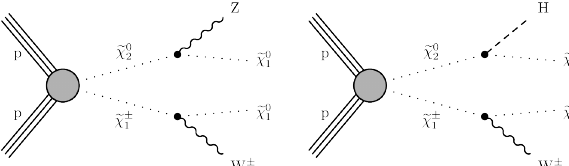
Figure 12: Chargino and neutralino pair production with the chargino decaying to a W boson and the LSP and the neutralino decaying to (left) a Z boson and the LSP or (right) a Higgs boson and the LSP [ 20 ] .